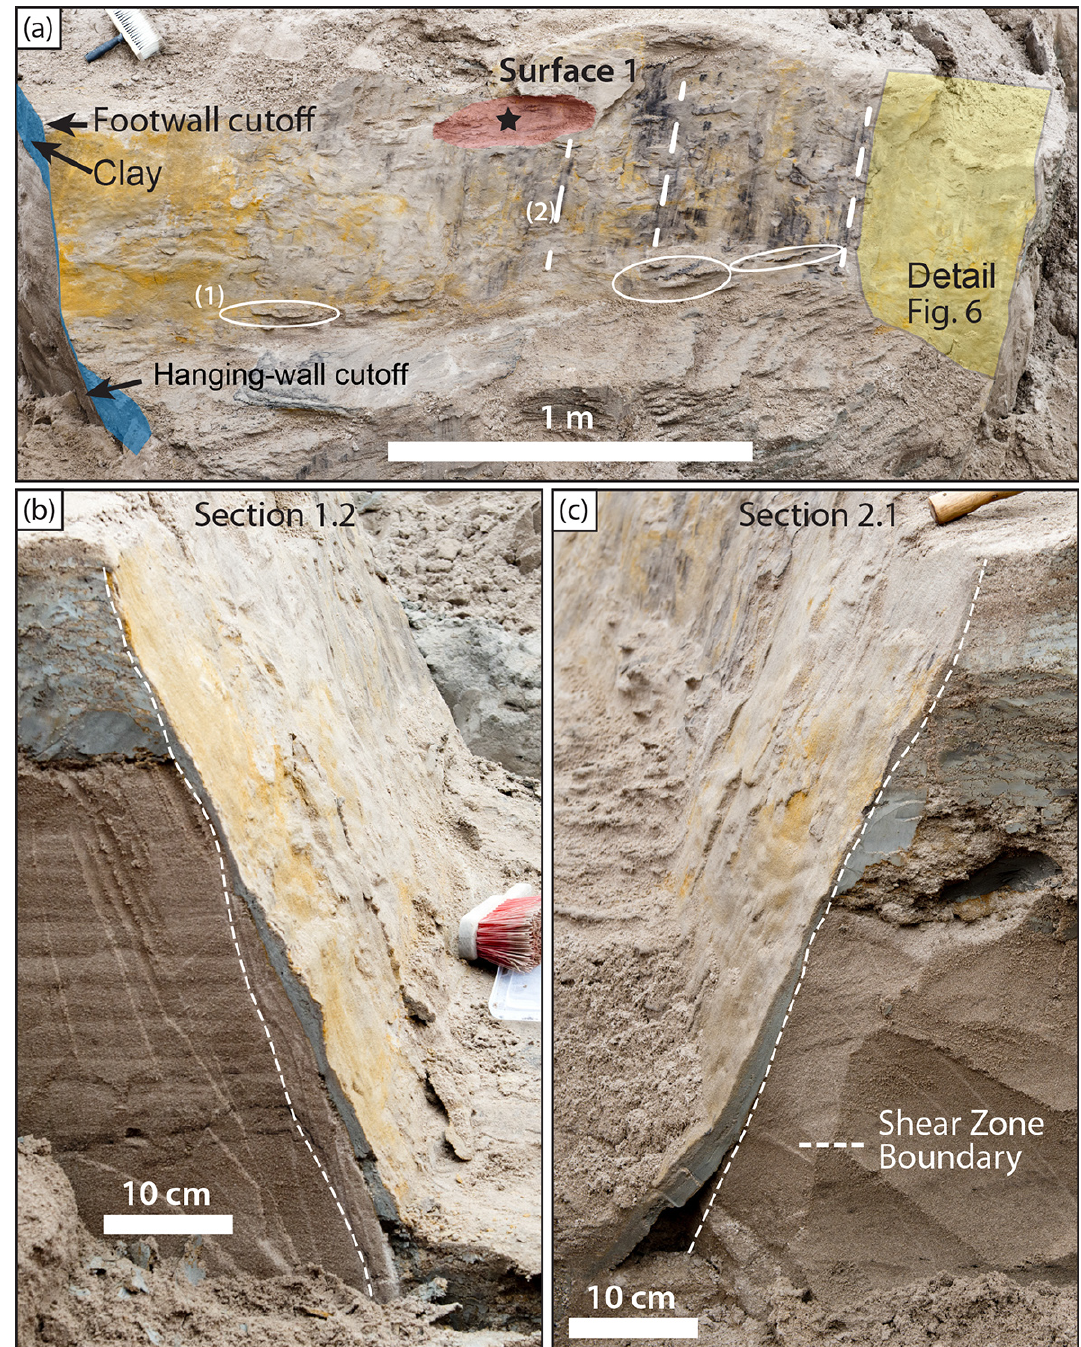
Figure 5. (a) excavated surface 1 and corresponding vertical profiles, (b) 1.2 at the NW side and (c) 2.1 at the SE side. Shear zone boundaries are indicated by dashed lines in the profiles. Note the thickness variation of the clay smear, with the thickest part in the middle of profile 1.2.